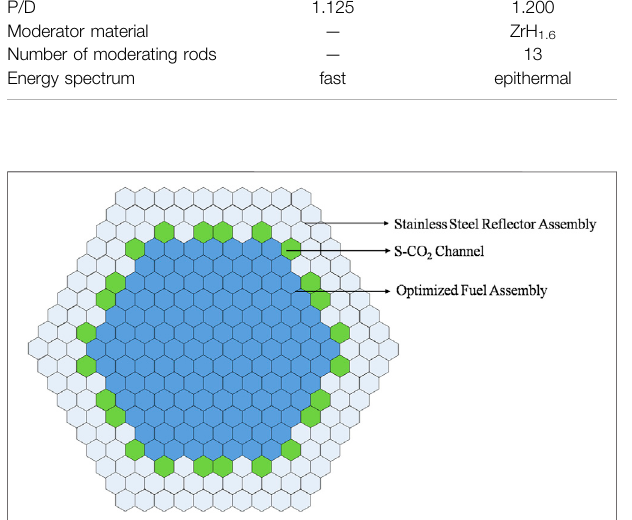
FIGURE 13 | The optimized S-CO 2 – cooled core.